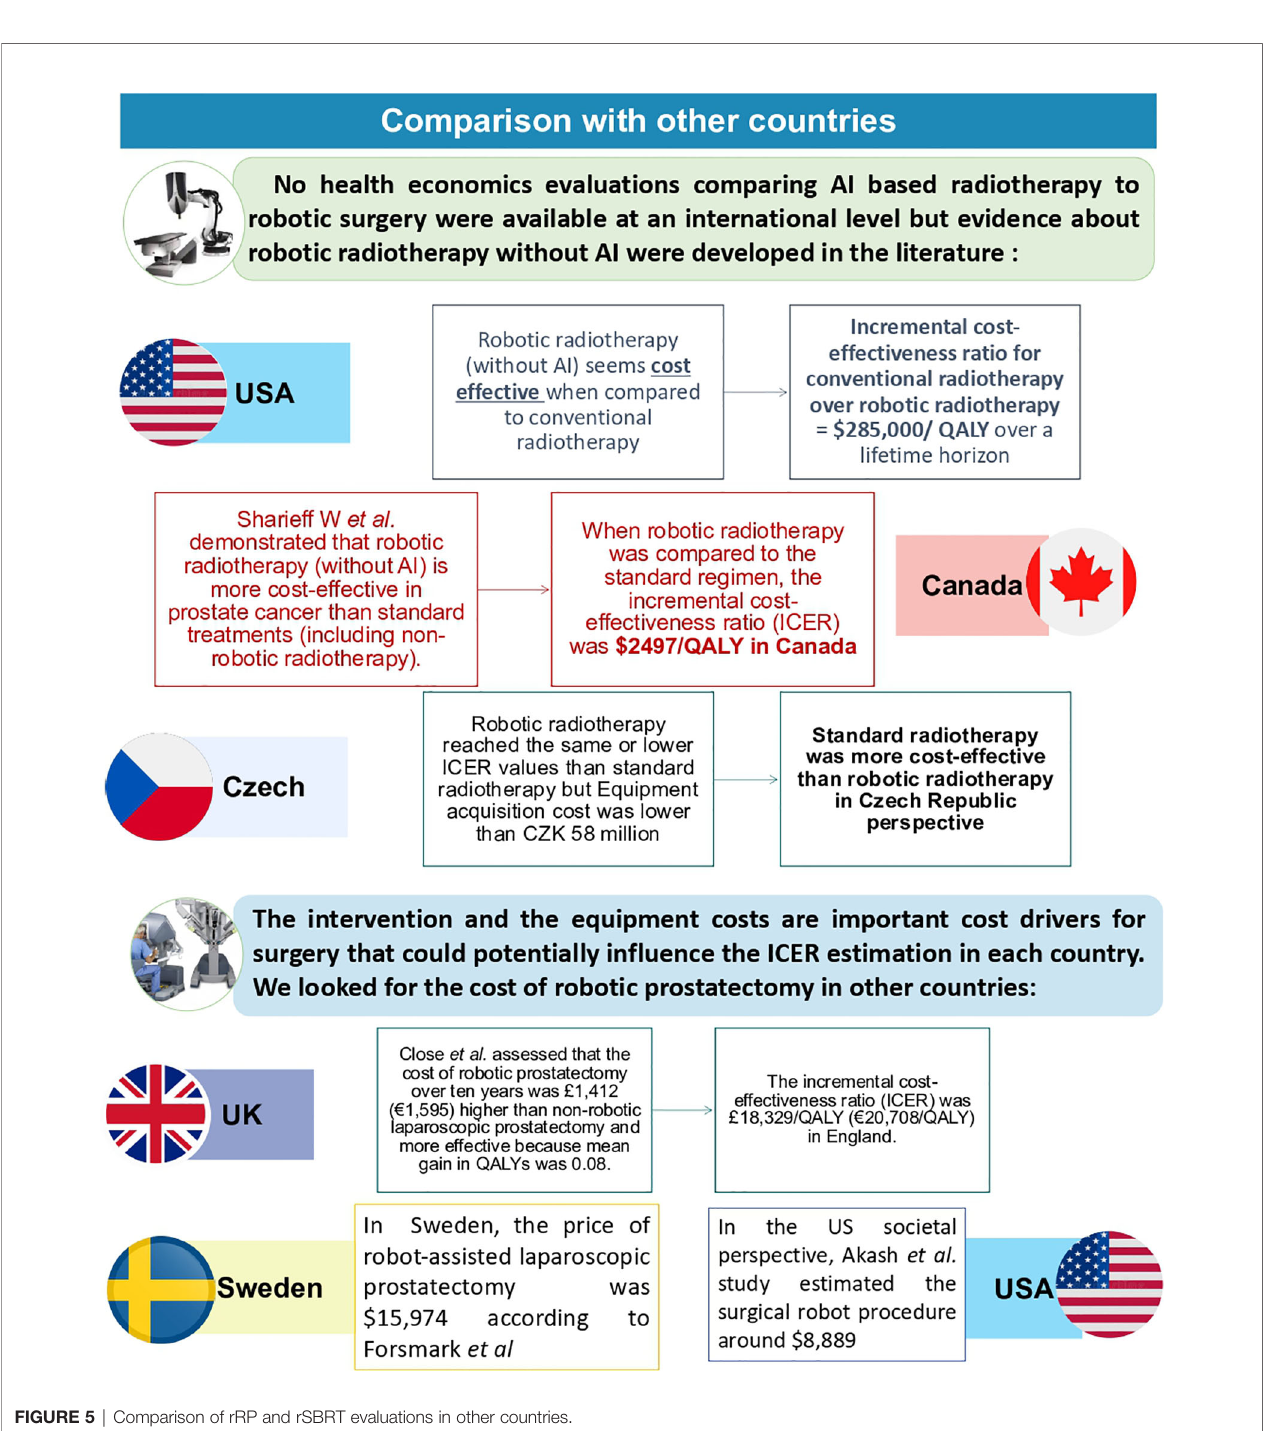
FIGURE 5 | Comparison of rRP and rSBRT evaluations in other